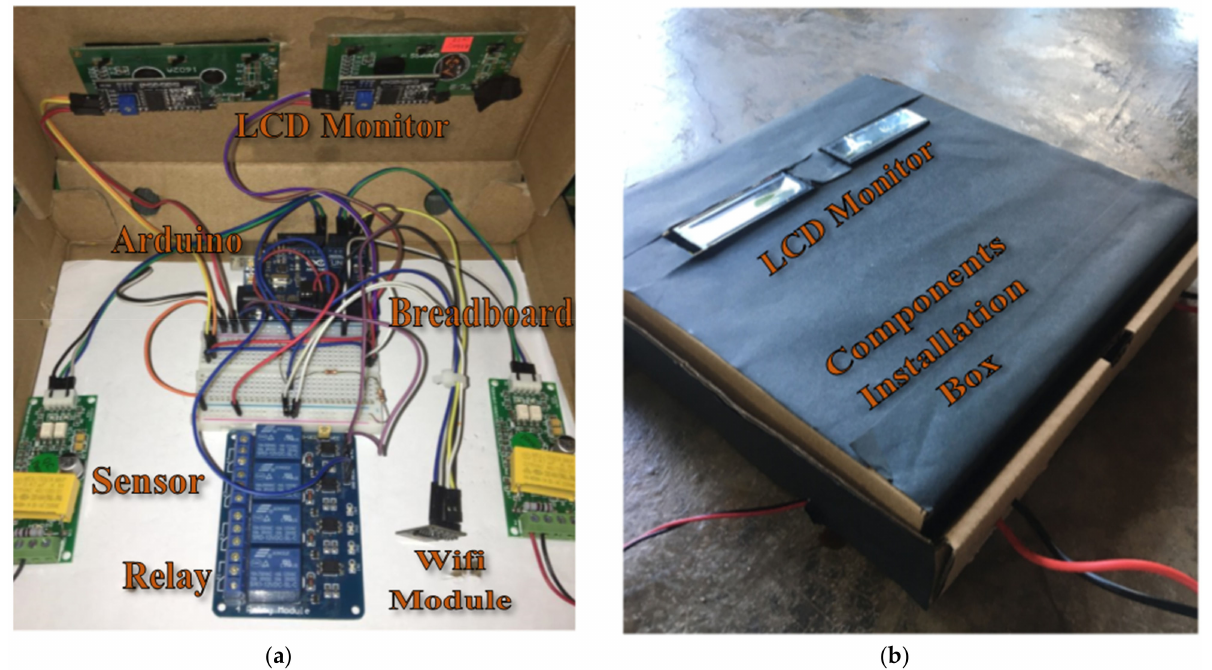
Figure 3. Developed ISHDB hardware prototype; ( a ) inside a box and ( b ) outside view.